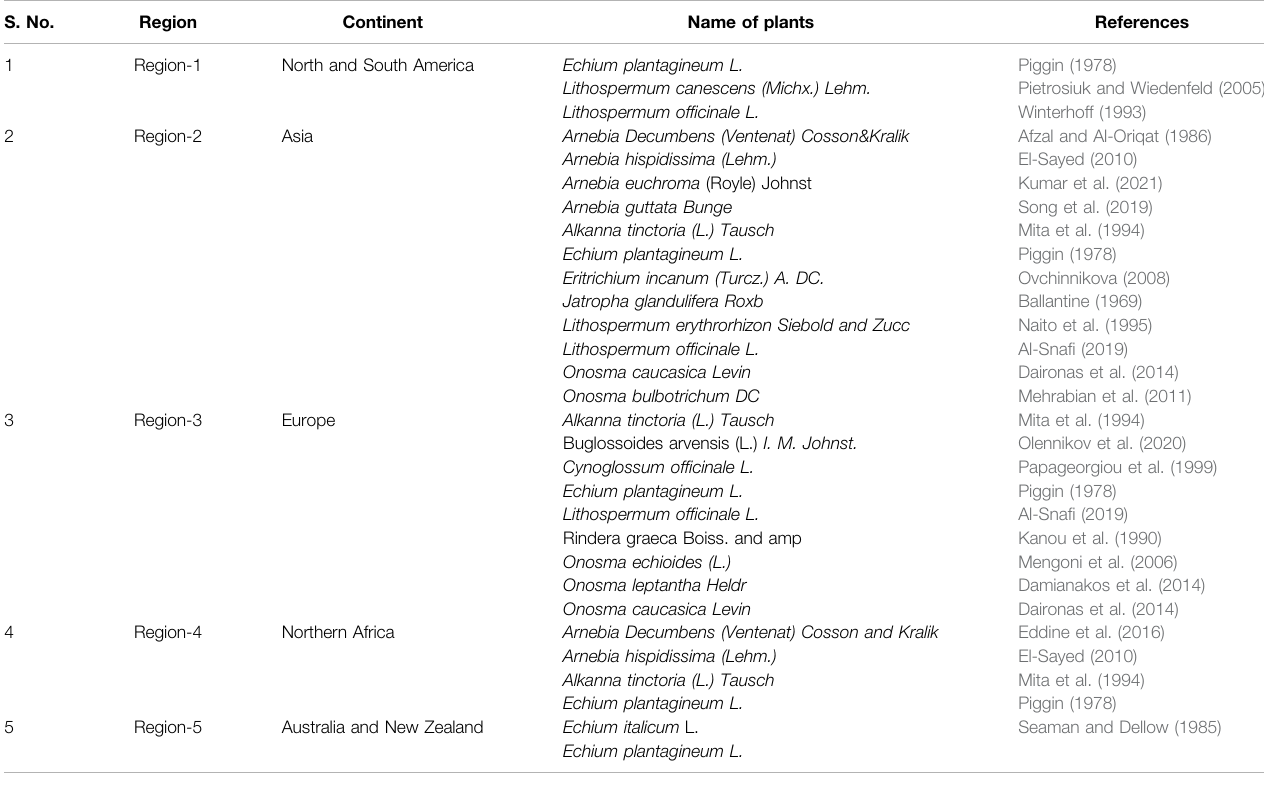
TABLE 2 | Sources of shikonin around the world.